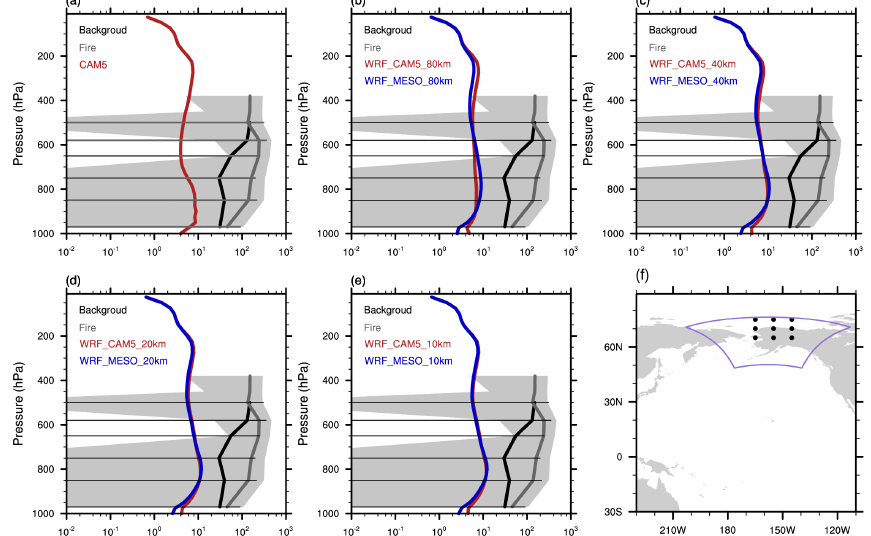
Fig. 12. Monthly mean vertical profiles of BC mixing ratio (ngkg − 1 ) from model simulations that uses the CAM5 (red) or WRF (blue) physics suite, compared with observations from the ARCPAC field campaign (dotted area). The purple line encloses the area of the WRF